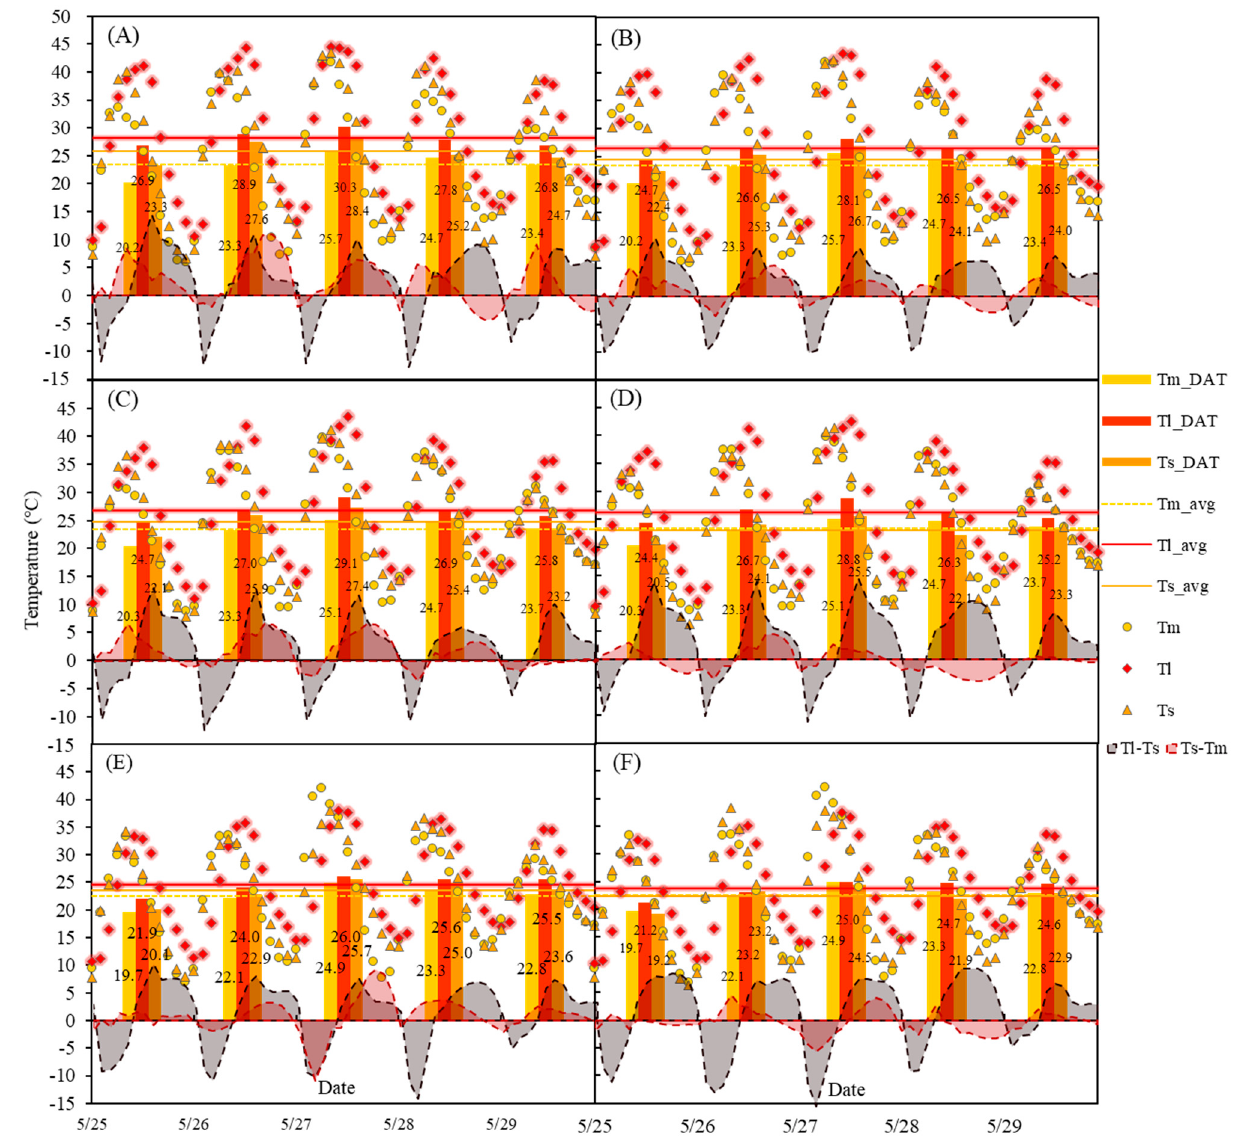
Figure 6. Variations in plastic film temperature ( T m _ DAT ), soil surface temperature ( T s _ DAT ), temperature below the soil surface ( T l _ DAT ), the difference between T l and T s ( T l − T s ) , the difference between T s and T m ( T s − T m ) , daily average temperature for the plastic film ( T m _ avg ), soil surface ( T s _ avg ) and 10 cm below the soil surface ( T l _ avg ), and the overall average temperatures for film, soil surface, and soil at 10 cm depth between 25 May and 30 May ( T m _avg, T s _avg, T l _avg, respectively) for the six treatments: ( A ) T1; ( B ) T2; ( C ) B1; ( D ) B2; ( E ) G1; ( F ) G2.